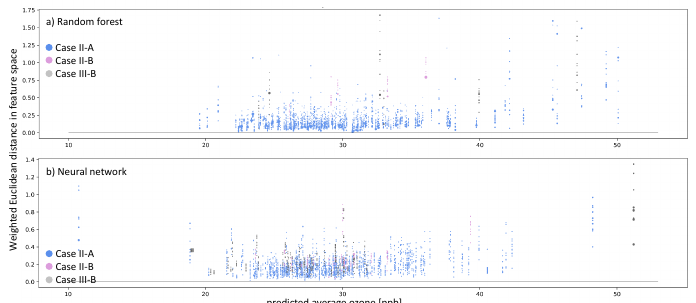
Figure 10. Similar to Figure 9, but the colors indicate the type of inaccurate prediction (navy blue and plum dots). Moreover, additionally to inaccurate predictions, we also show instances of Clever-Hans, where the residual error ∆ < 5 ppb, but there are no nearest neighbors in the models’ representation space (gray dots).